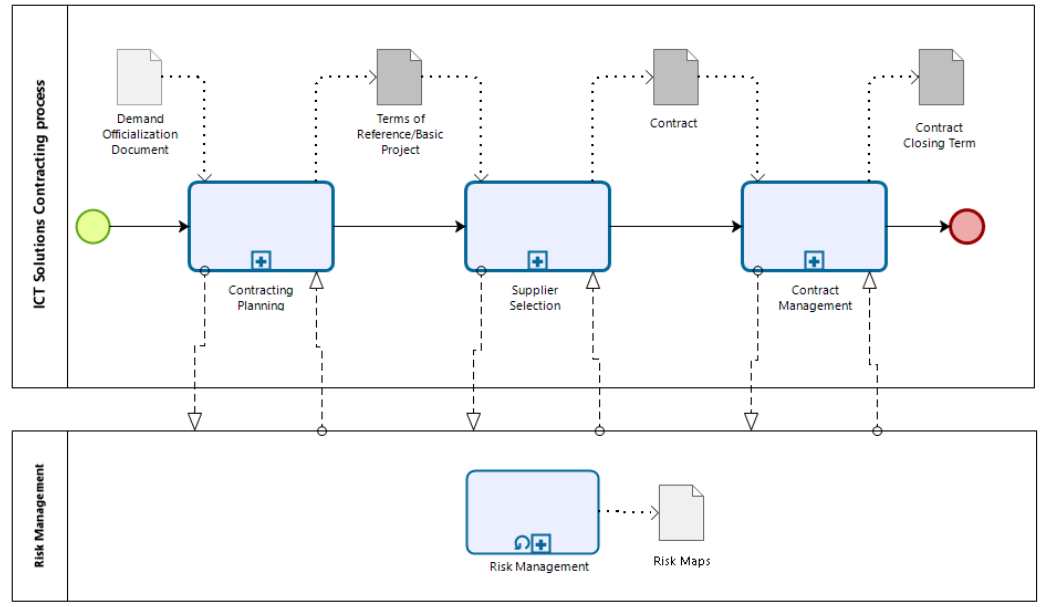
Figure 2. Phases of the Information and Communication Technology (ICT) solutions contracting